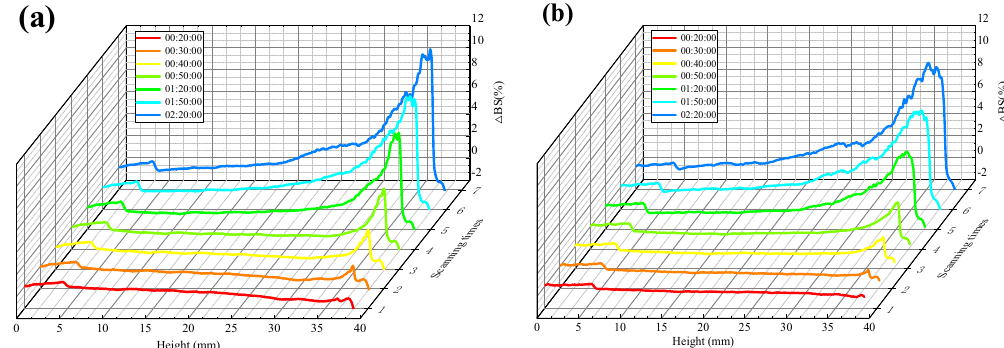
Figure 6. ΔBS (backscattering) profiles of the coal slurry as a function of settling time with and without polystyrene particles. ( a ) with polystyrene particles; ( b ) without polystyrene particles.